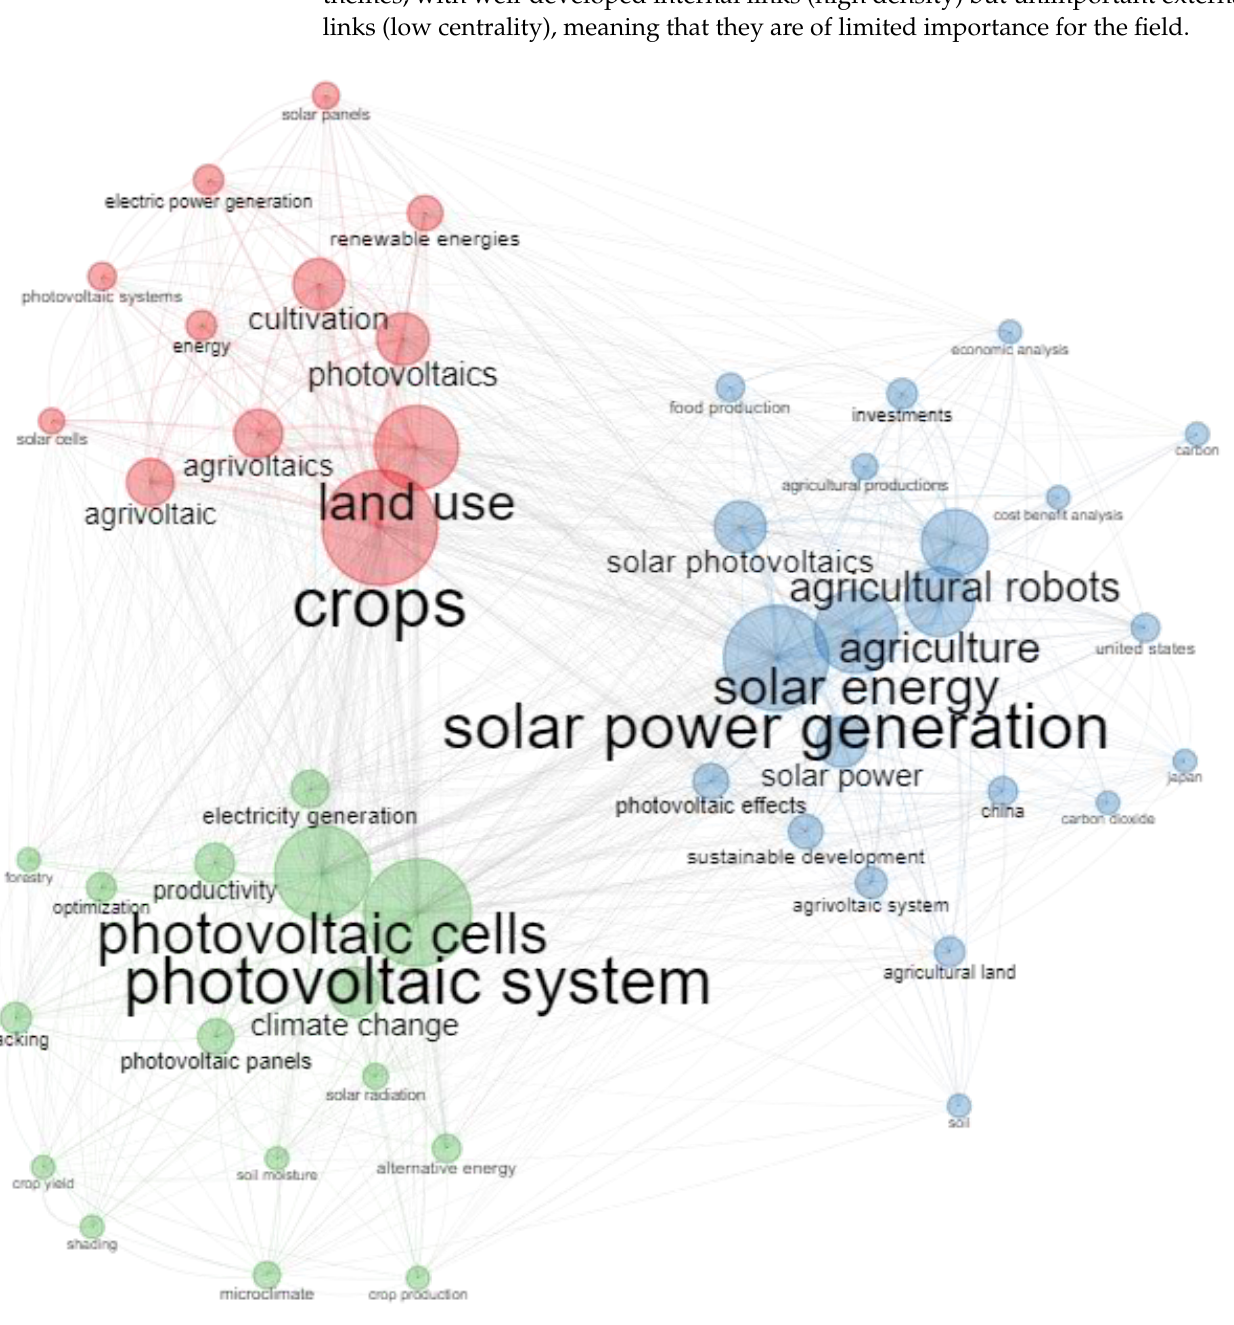
Figure 5. Keyword co-occurrence network. Source: created by the authors.